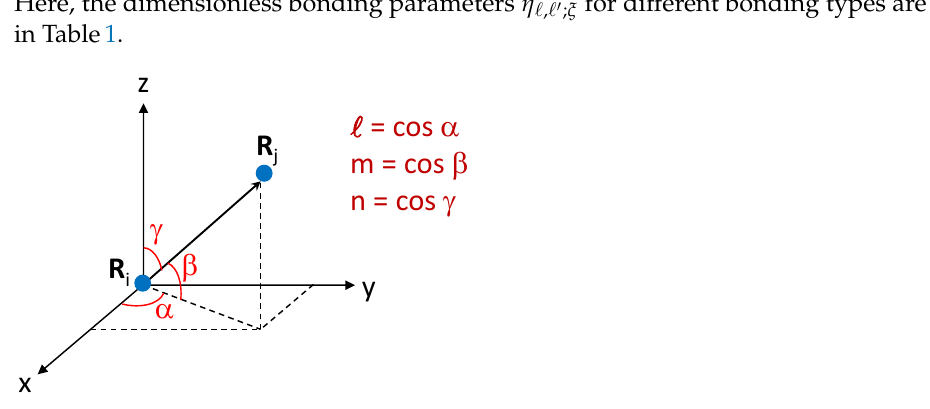
Figure 2. Illustration for three directional cosines (cid:96) , m , n in a three-dimensional position space for two atoms sitting at r = R i and r = R j , respectively.